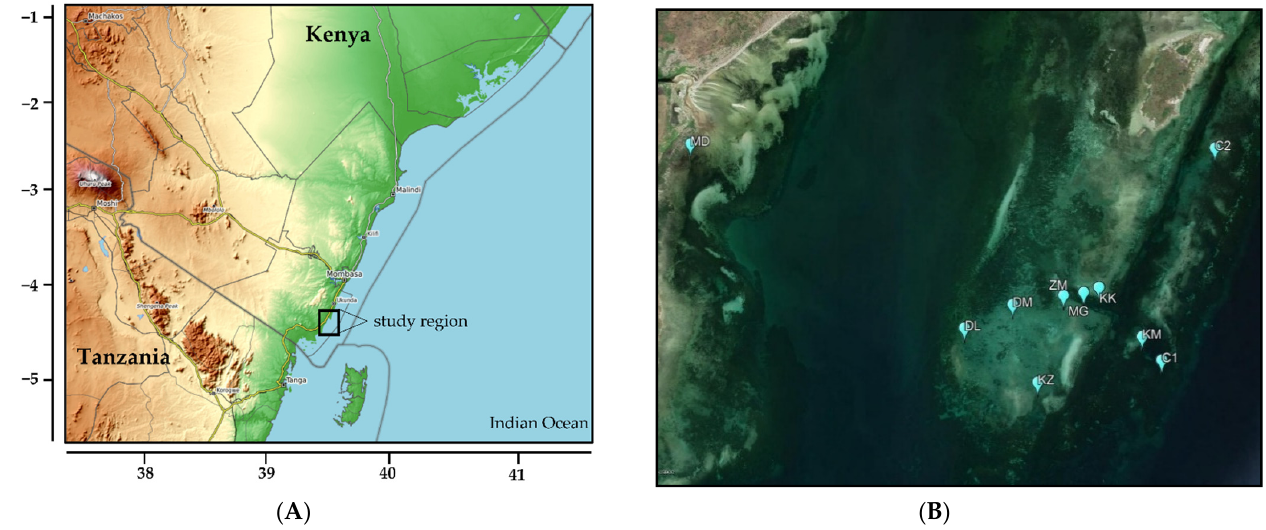
Figure 1. ( A ) Location of the study region on the southern Kenyan coast of East Africa; the scales indicate latitude south of the equator and longitude east of the prime meridian. Color on land indicates altitude. ( B ) Aerial image of Gazi Bay showing the location of the ten study sites: Chale 1 (C1), Chale 2 (C2), Doa Lower (DL), Doa Upper (DM), Kijamba Mkandi (KM), Kiziwa Kule (KZ), Kukuni (KK), Mikingamo (MG), Mikingamo 2 (ZM), Mwandamo (MD) (Satellite image © Google).